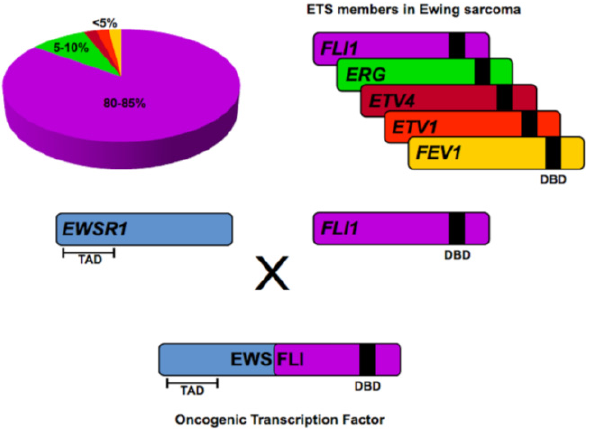
Figure 2. EWS/ETS fusions in Ewing sarcoma. EWS/FLI fusions comprise 80 (cid:177) 85% of all translocations in Ewing sarcoma. Translocations involving other ETS family members such as ERG , ETV4 , ETV1 and FEV1 are less common. In all instances, the transcriptional activating domain (TAD) in the N-terminus of EWS is fused to the C-terminal DNA binding domain (DBD) of the ETS family member. The resultant chimeric fusion protein functions as a potent oncogenic transcription factor responsible for tumorigenesis in Ewing